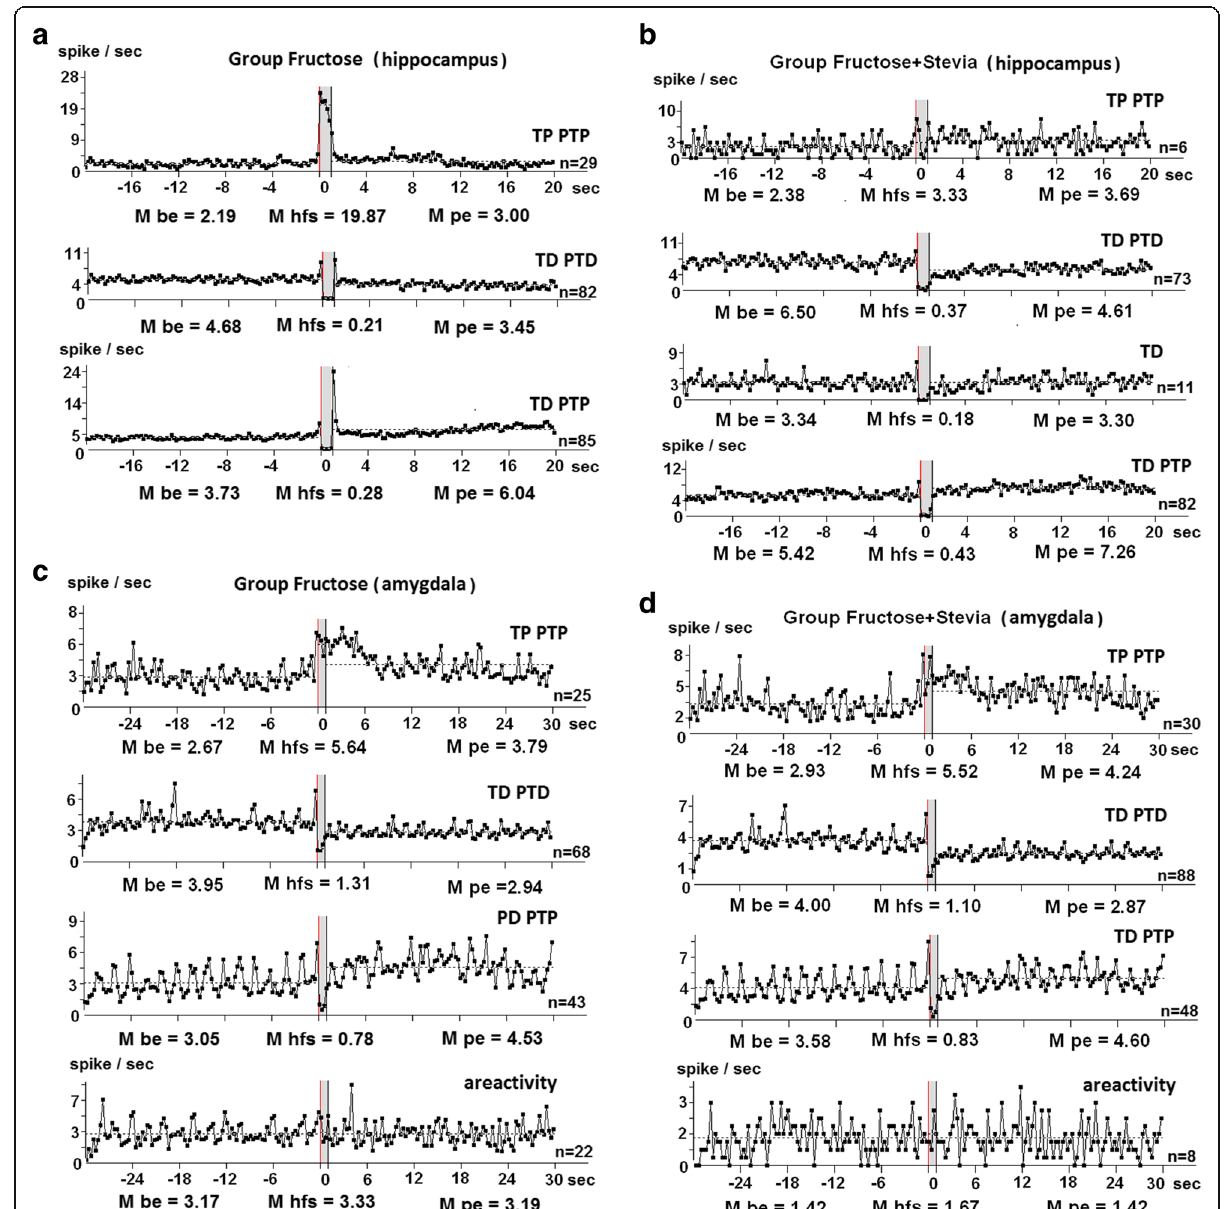
Fig. 2 Peristimulus mean frequency diagrams, built on the basis of pre-and post-stimulus manifestations of spike activity of single hippocampal neurons to entorhinal cortex high-frequency stimulation ( a , b ) and in single neurons of the amygdala during high-frequency stimulation of the hippocampus ( c , d ) in real time and 20 to 30 s before stimulation (Mbe), 20 and 30 s after stimulation (Mpe) and during high-frequency stimulation (Mhfs) exhibiting the specified type of responses (TP PTP, TD PTD, TD PTP) and areactivity in Group-F ( a , c ) and Group-F+St ( b , d ). Mbe (mean frequency of spikes during time interval before stimulation), Mpe (mean frequency of spikes during time interval after stimulation), Mhfs (mean frequency of spikes during high-frequency